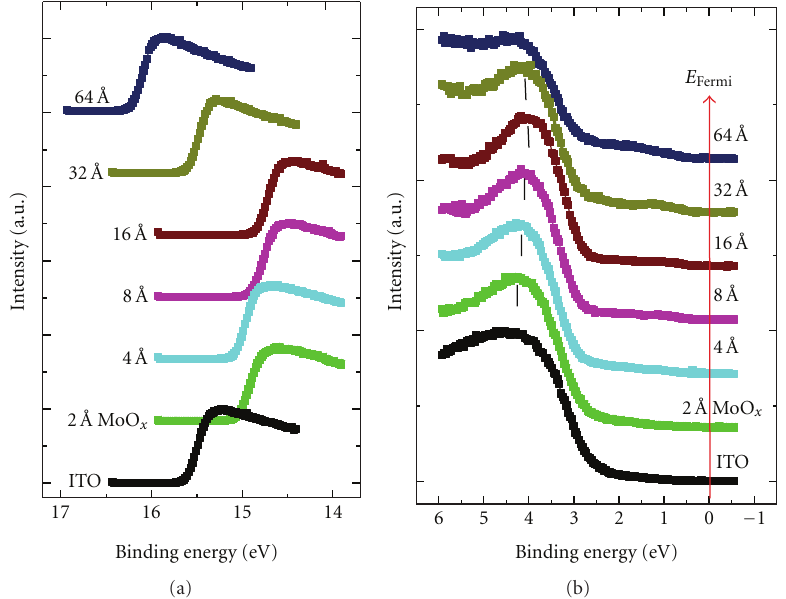
Figure 1: UPS data for ITO, 2 ˚A, 4 ˚A, 8 ˚A, 16 ˚A, 32 ˚A, and 64 ˚A MoO 2 for (a) the cut-o ff region and (b) the valence region.